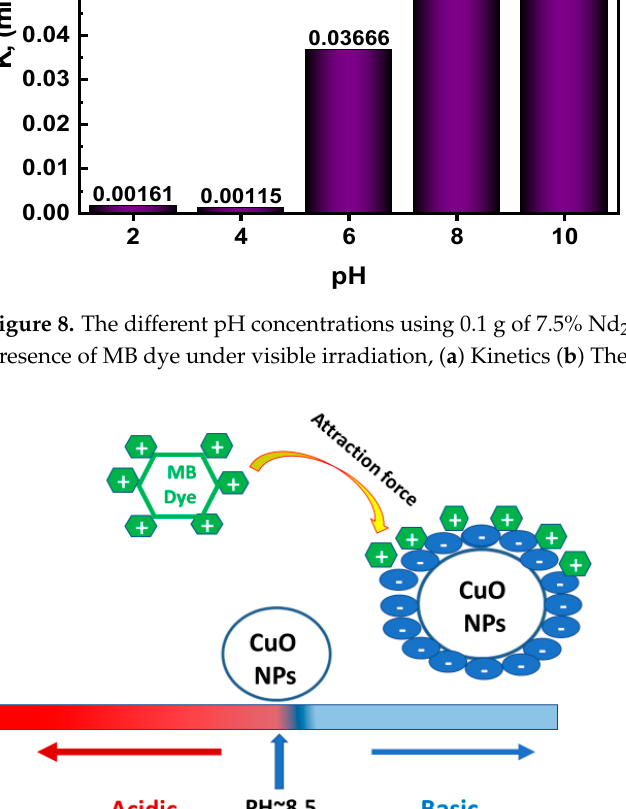
Figure 8. The different pH concentrations using 0.1 g of 7.5% Nd 2 O 3 doped CuO nanoparticle in the presence of MB dye under visible irradiation, ( a ) Kinetics ( b ) The rate